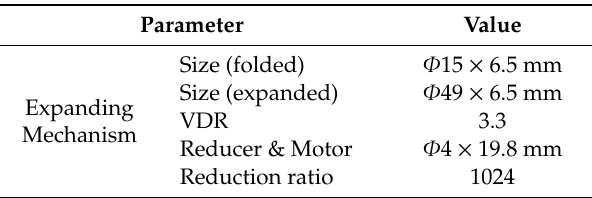
Table 1. Parameters of mechanical structure.